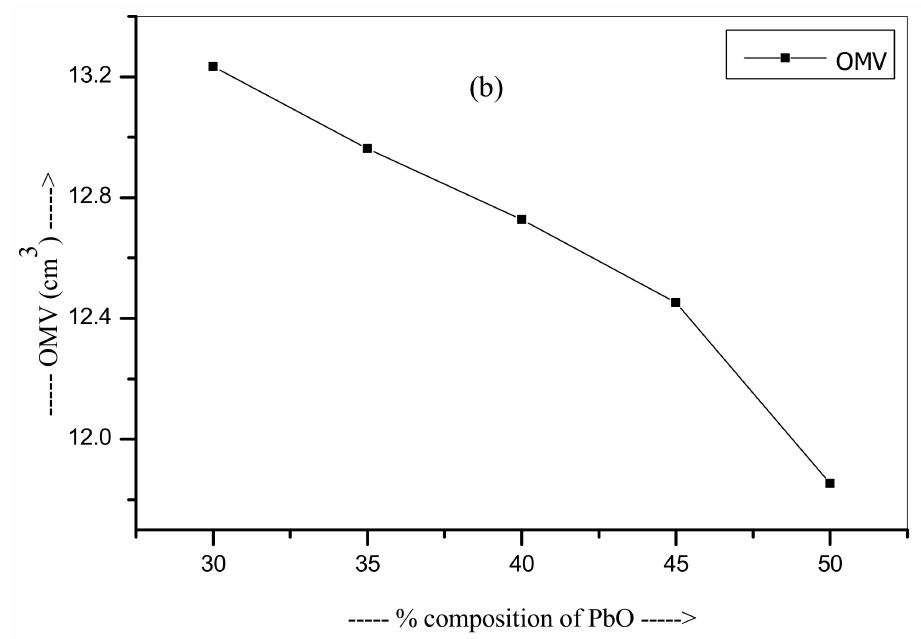
Figure 1. Variation of ( a ) OPD ( b ) OMV with % composition of PbO.